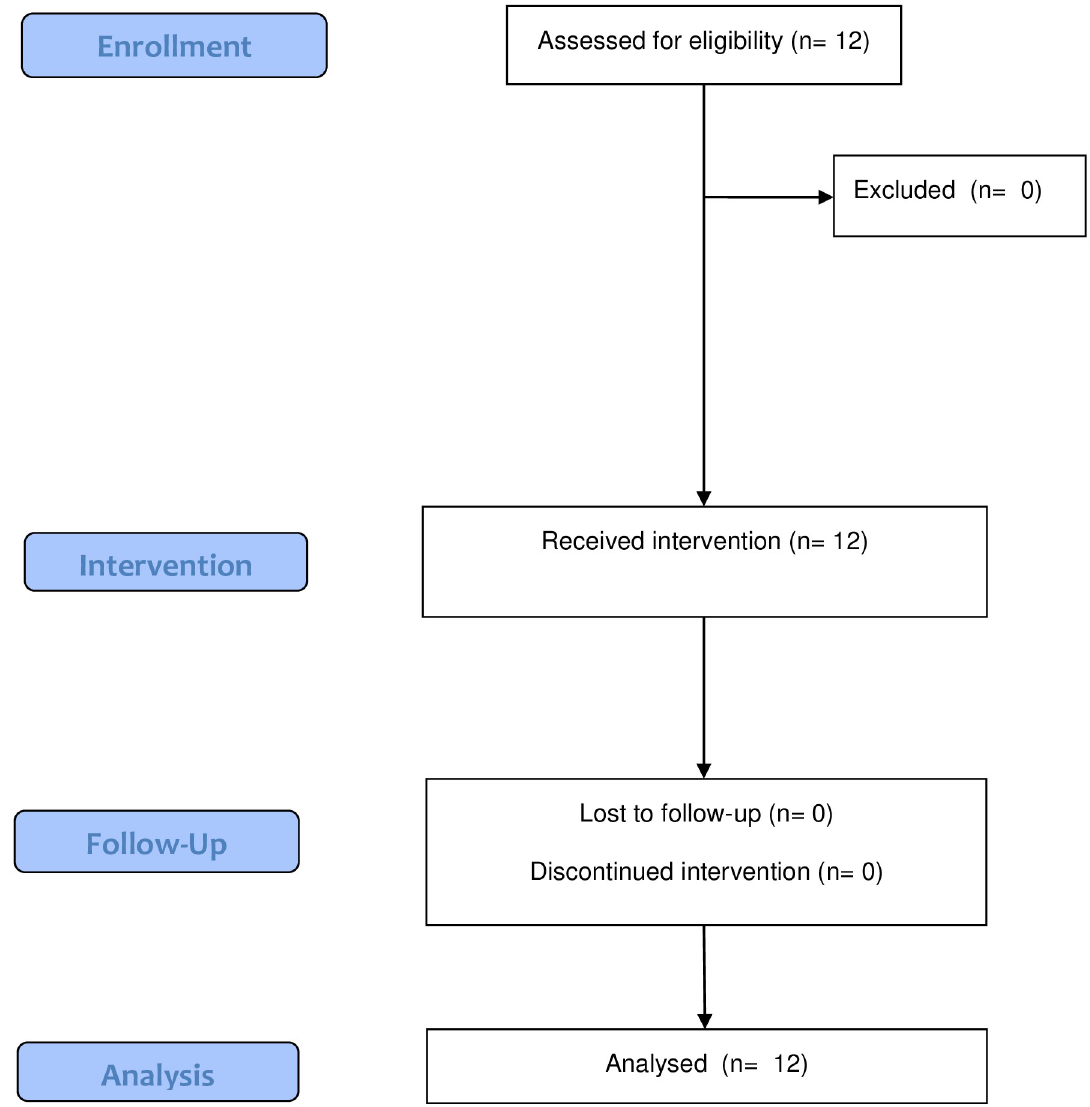
Fig 1. Flow diagram of participants enrolled and analyzed in this